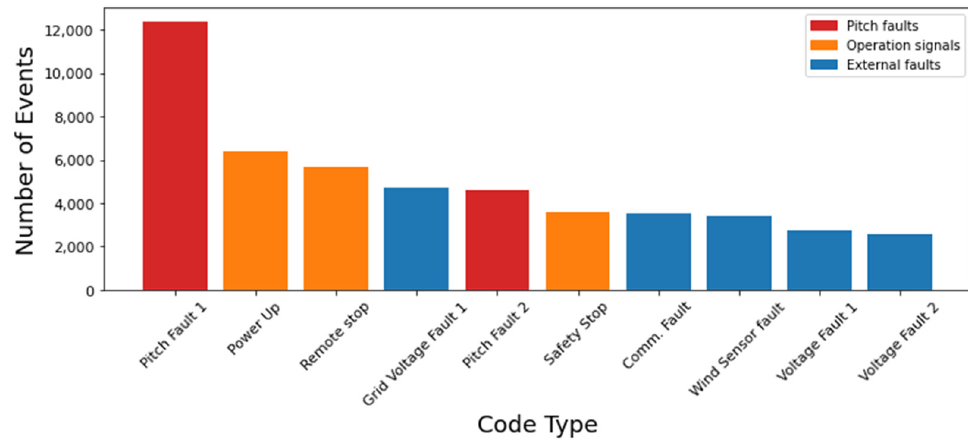
Figure 4. Breakdown of top alarm events recorded in the